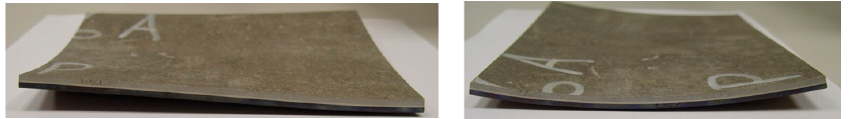
Figure 2. Explosive welded sheet of AA2519-Ti6Al4V with interlayer of AA1050 after heat treatment.